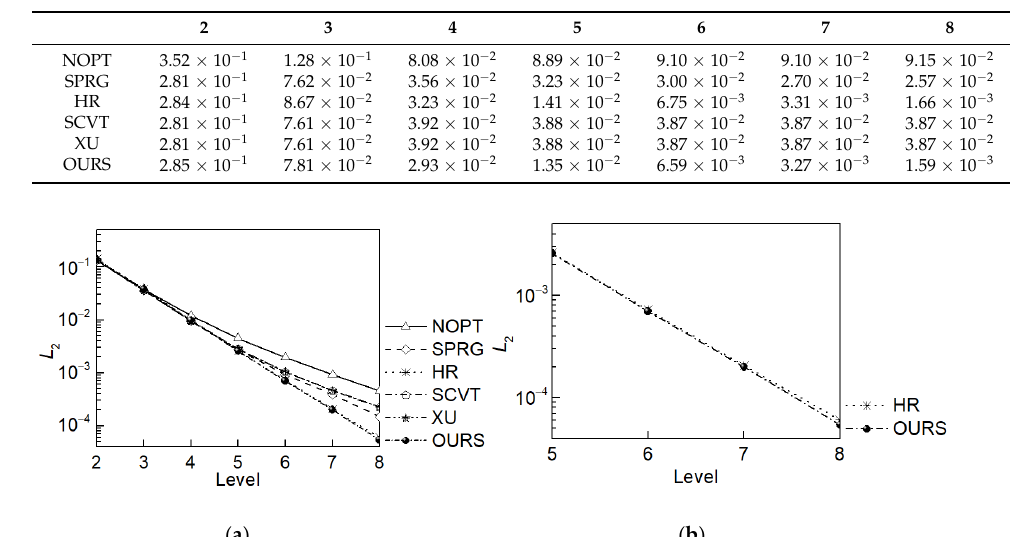
Table 12. L ∞ ‐ norm error of Laplacian operator of different grids.